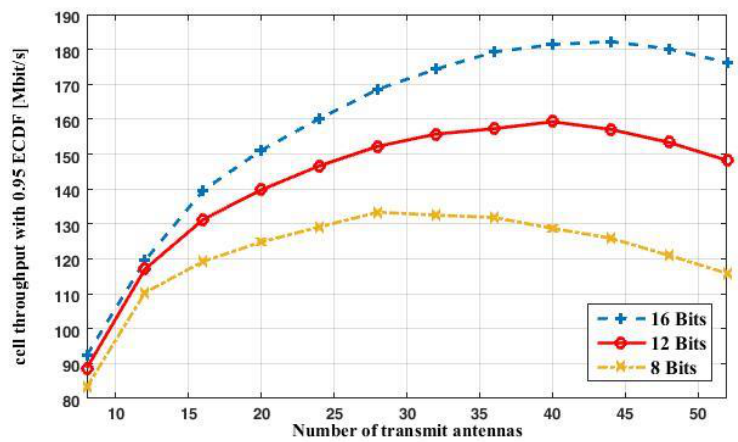
Figure 6. The considered system with DAS configuration, where the UCIC strategy is applied to the system, and di ff erent numbers of transmit antennas and feedback bits are